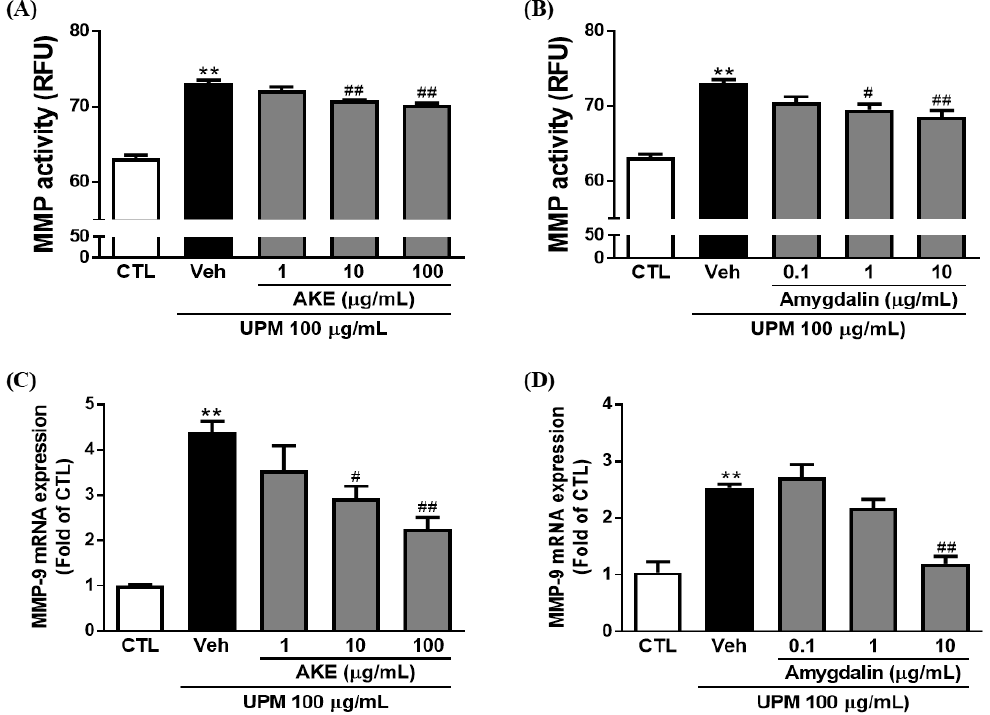
Figure 5. Effects of AKE on matrix metalloproteinase induced by UPM in the conjunctival epithelial cells. Conjunctival cells were treated with AKE or amygdalin 1 h before UPM exposure. ( A ) and ( B ) Activity of matrix metalloproteinase (MMP). ( C ) and ( D ) mRNA expression of MMP-9. Control group: CTL; vehicle group: Veh; AKE-treated group: AKE; urban particulate matter-treated group: UPM. Data shown are mean ± standard error of the mean (n ≥ 3). ** p < 0.01 vs. CTL, # p < 0.05 or ## p < 0.01 vs. Veh.